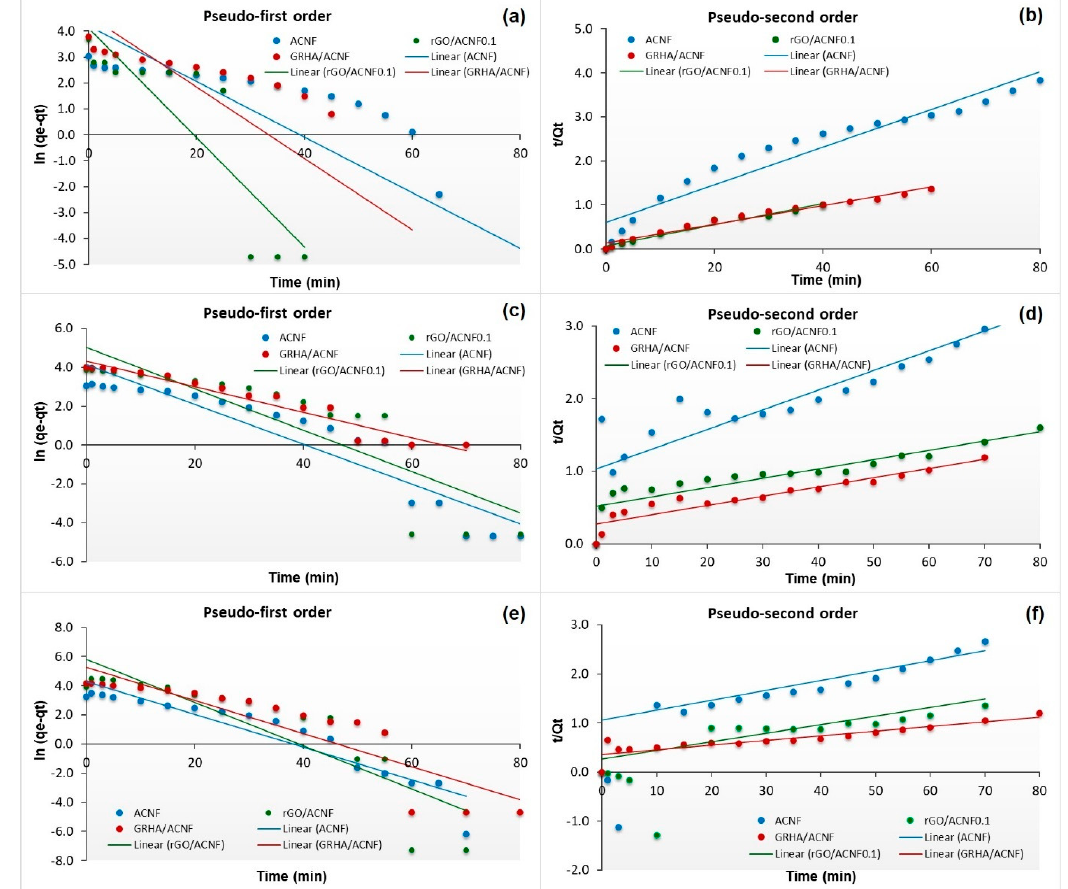
Figure 9. Kinetic adsorption of pseudo-first- and pseudo-second-order models of all ACNF samples at different pressures ( a , b ) 4 bar, ( c , d ) 8 bar, and ( e , f ) 12 bar. Table 4. Kinetic parameters of pseudo-first-order and pseudo-second-order for ACNF, rGO/ACNF, and GRHA/ACNF at different adsorption pressures.